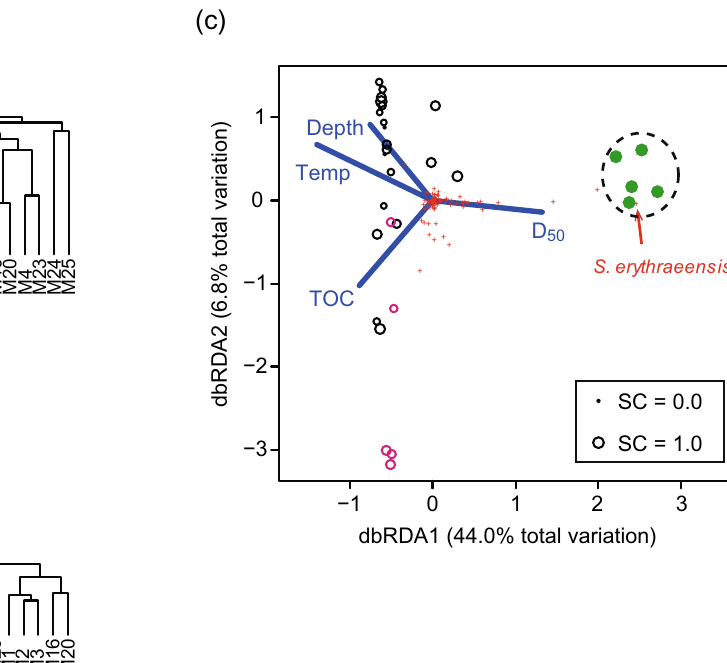
Figure 3. Community structure in Matsunaga Bay. Dendrograms based on ( a ) Sørensen dissimilarity and ( b ) log( n + 1) Euclidean distance. ( c ) Model-selection results in the redundancy analysis based on log( n + 1) Euclidean distance. Dots in ( a ) and ( b ) indicate reliable observations (data from at least 50 individuals). Green and magenta circles indicate observations from intertidal flats at the mouth of a small river and in the inner bay, respectively. The size of the circles in ( c ) represents sample coverage (SC). Open and closed circles in the panels indicate unreliable (from fewer than 50 individuals) and reliable observations (50 or more individuals), respectively. Red crosses indicate benthic invertebrate species. Simplisetia erythraeensis was the most dominant species at the mouth of the small river.